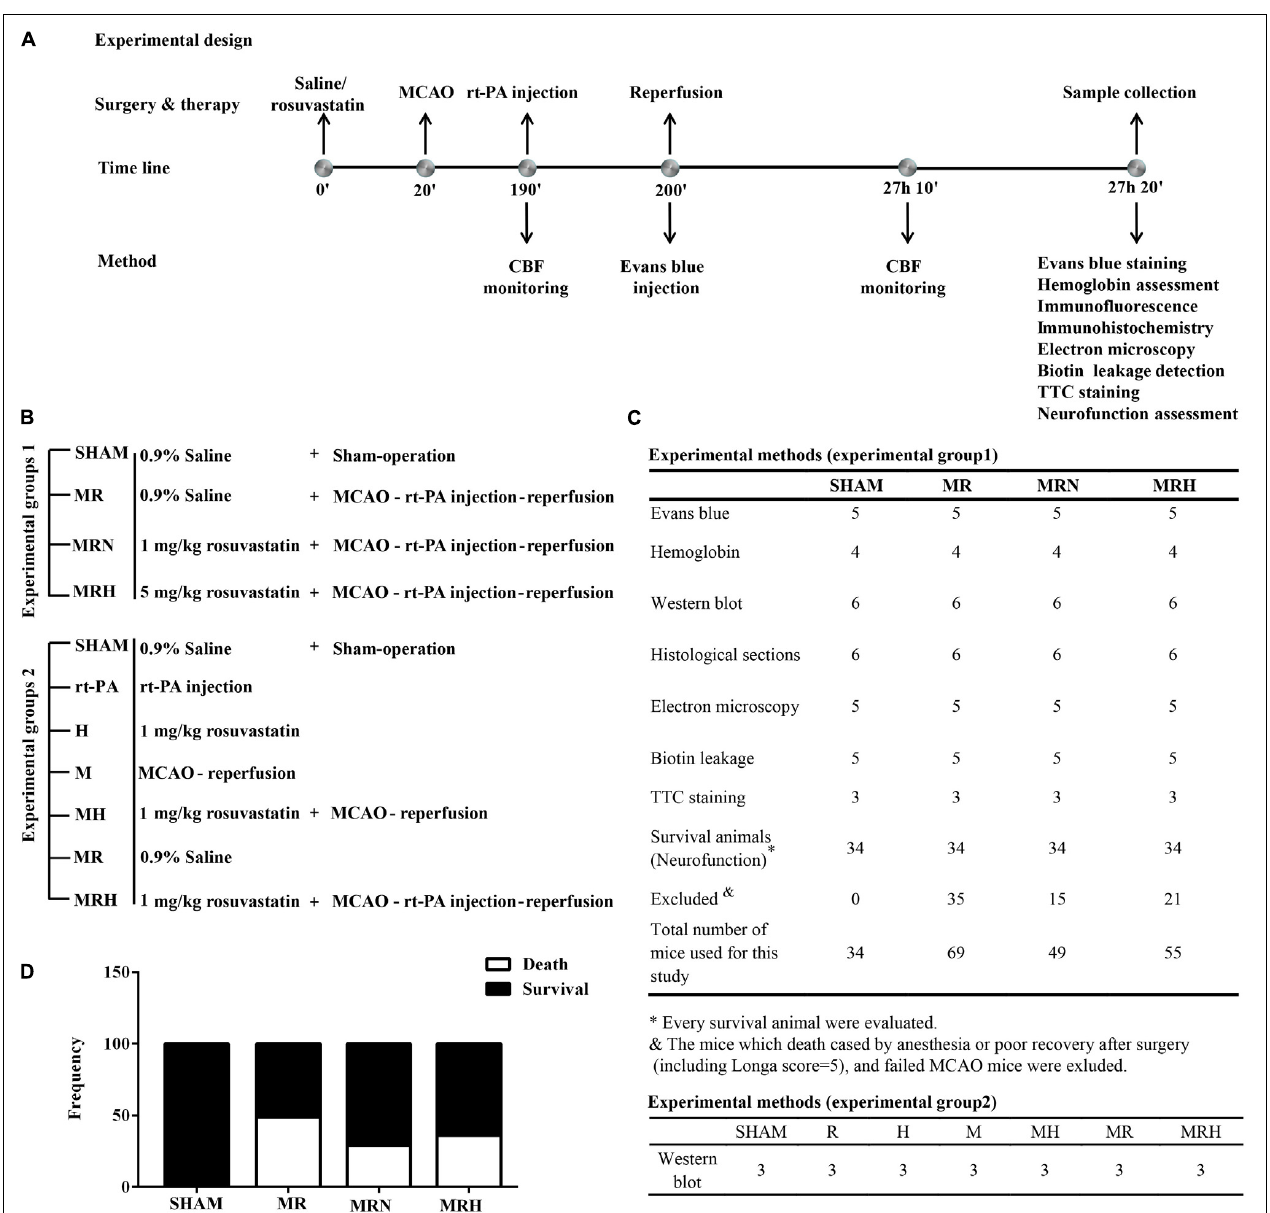
FIGURE 1 | Schematic overview of the protocols. (A) Illustration of the protocols, including the time line of the experiments and tests. (B) The treatment groups of experiments 1 and 2. (C) The tests and numbers of mice in experiments 1 and 2. (D) The frequencies of death and survival in mice, which were analyzed by chi-square